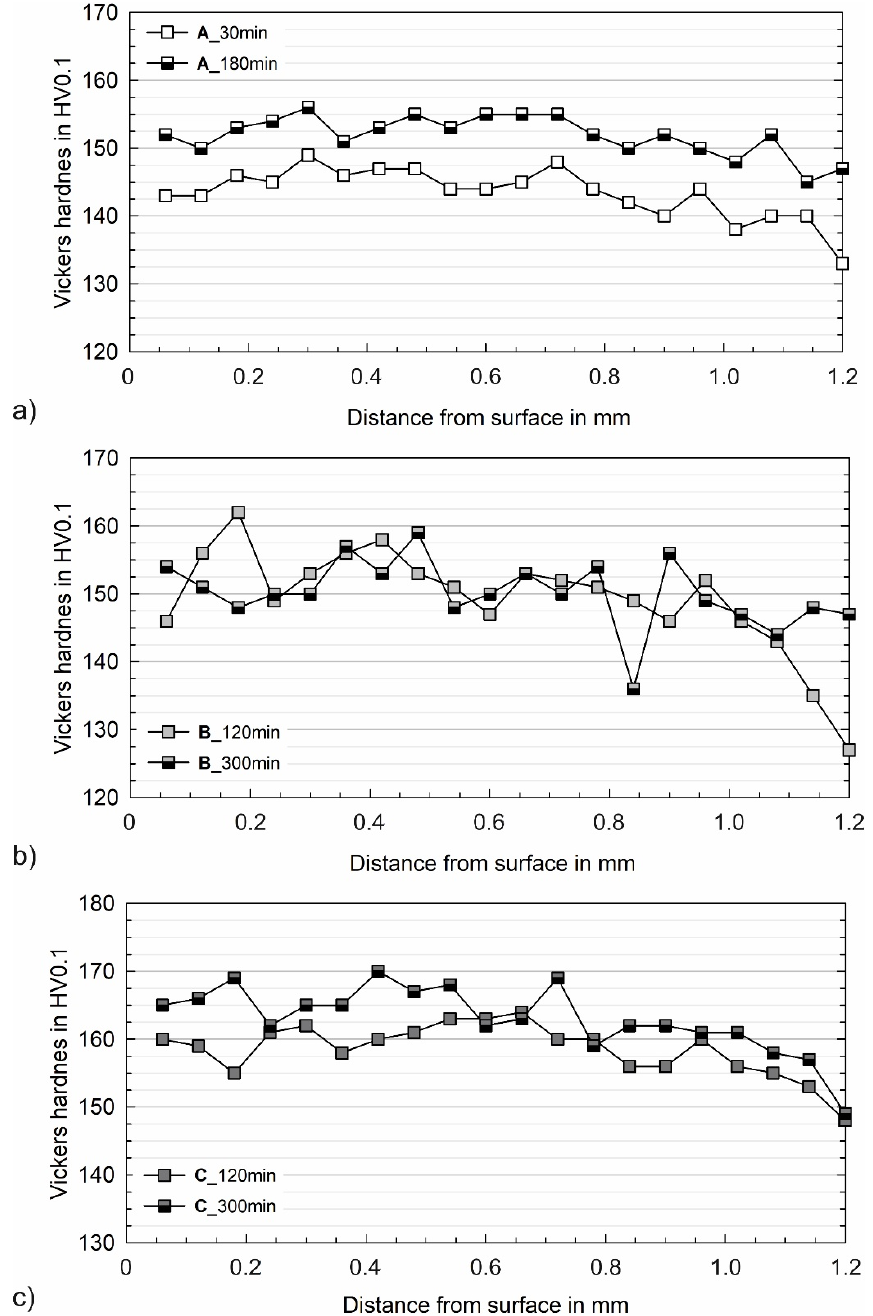
Figure 4. Vickers Hardness across half of the wire section measured for the three different processing routes dependent on the artificial aging time prior to thread rolling as a function of the surface distance: initial heat treatment condition ( a ) solution-annealed, ( b ) naturally aged and ( c ) pre-aged. For all processing routes and artificial aging times, the hardness decreases with the increasing distance from the surface.